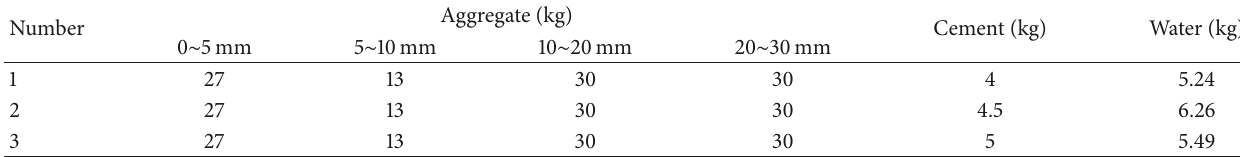
Table 3: Mixing proportion of each group for per 100 kg